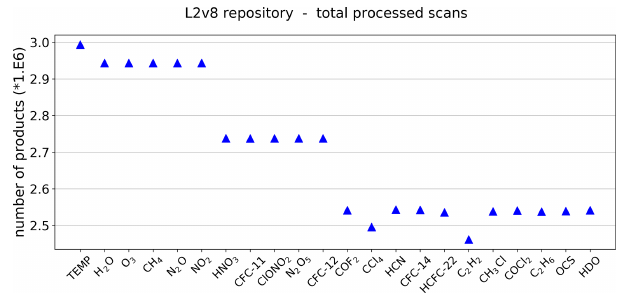
Figure 5. Total number of available profiles in the level2-v8 database for each